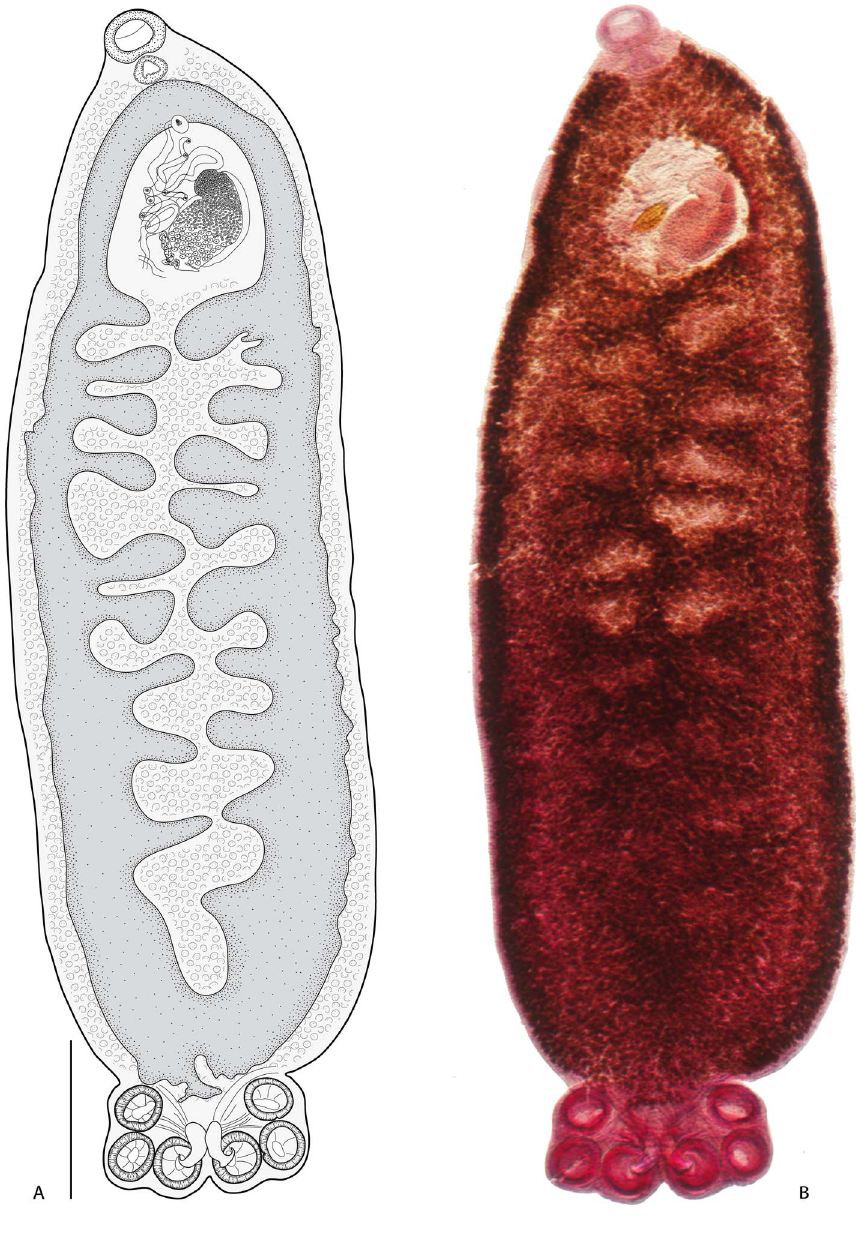
Figure 2. Indopolystoma viridi n. gen. n. sp. from Zhangixalus viridis . Dorsal view of holotype. (A) A drawing; (B) A photograph. Scale bar: 1